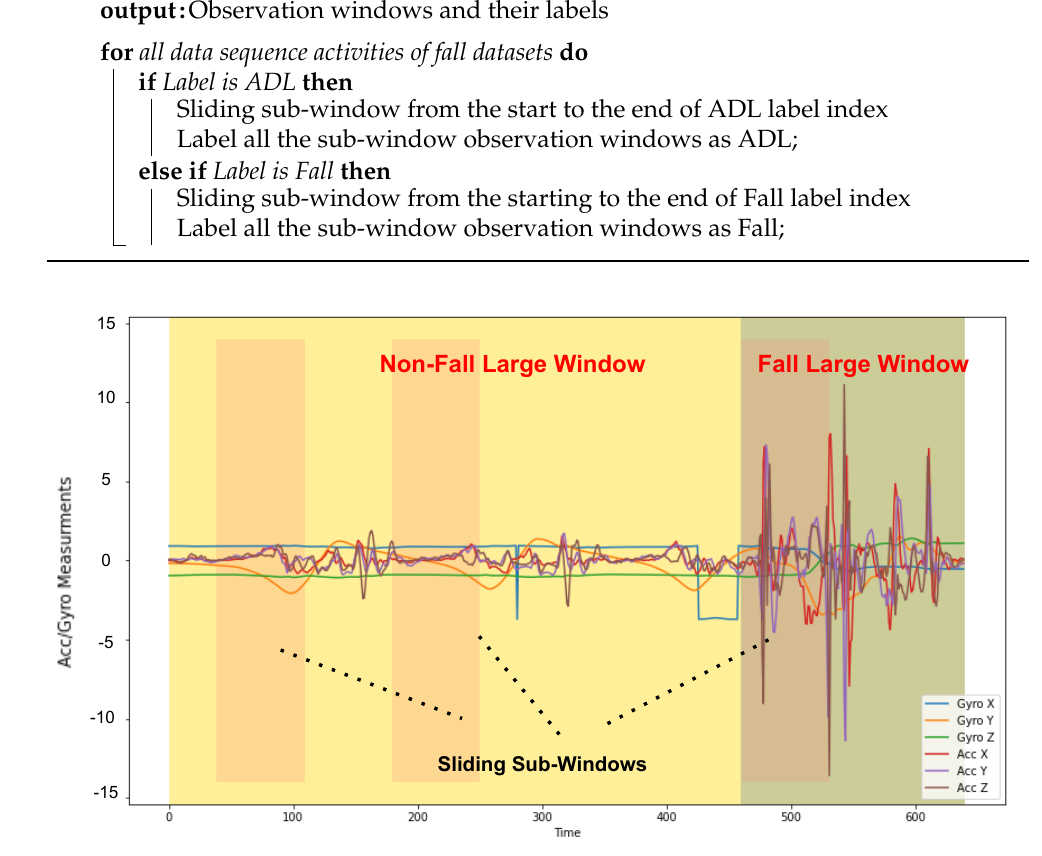
Figure 2. Sliding Multi-window feature